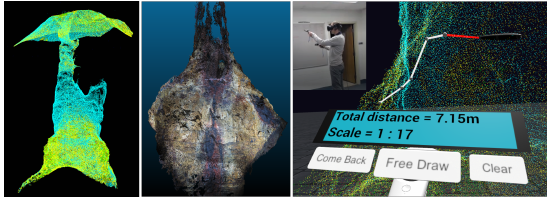
Figure 3. Thrihnukar experience in the immersive virtual environment (modified from (Zhao and Klippel, 2019a)). Left: terrestrial LiDAR data. Middle: Structure-from-Motion derived model preserving original point colors. Right: hand-based interaction with point clouds during length